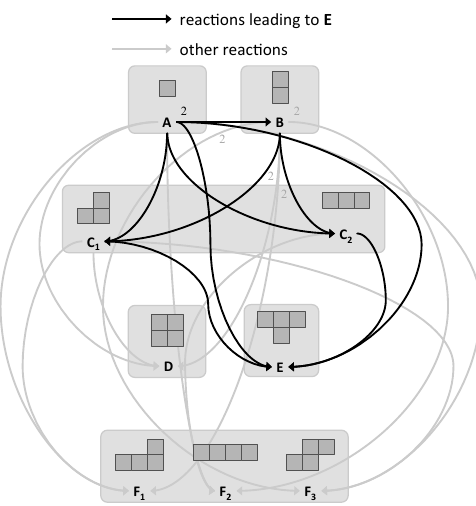
Figure 3. Graphical representation of all assemblies that can be formed out of four modules and the forward reactions giving rise to them. Chiral copies of assemblies F 1 and F 3 are not included. The shaded rectangles indicate assemblies with the same connection topology (using a four-neighbor topology). Black arrows denote the reactions that lead to the target structure E , whereas gray arrows other forward reactions in the system